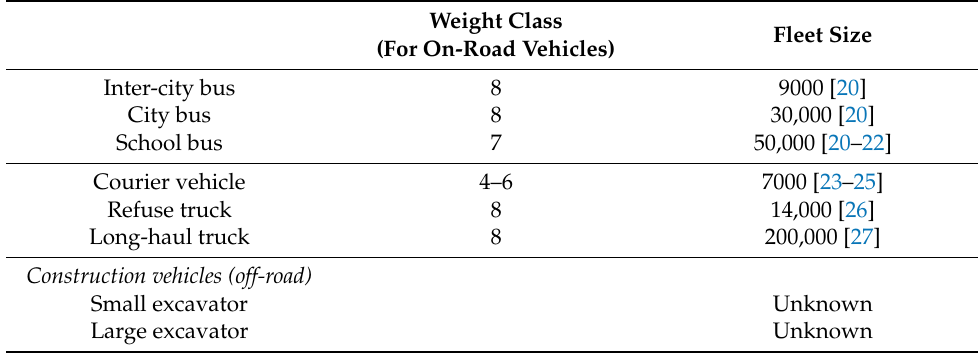
Table 1. MD/HD vehicles evaluated and estimated fleet sizes in Canada.